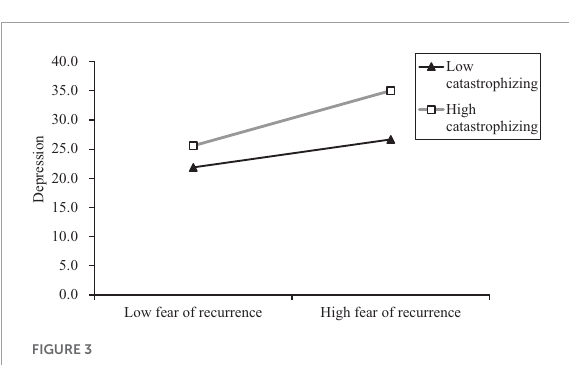
FIGURE2 Catastrophizing moderated the mediation model of fear of recurrence to invasive rumination to depression: Statistical diagram. ∗∗ p < 0.01; ∗∗∗ p < 0.001.